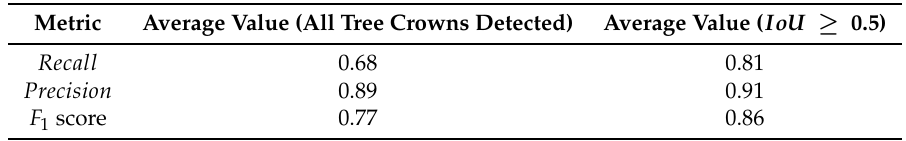
Table 7. Average values of evaluation metrics: Recall , Precision , and F 1 score for all tree crowns detected by Mask R-CNN and for the tree crowns with IoU value ≥